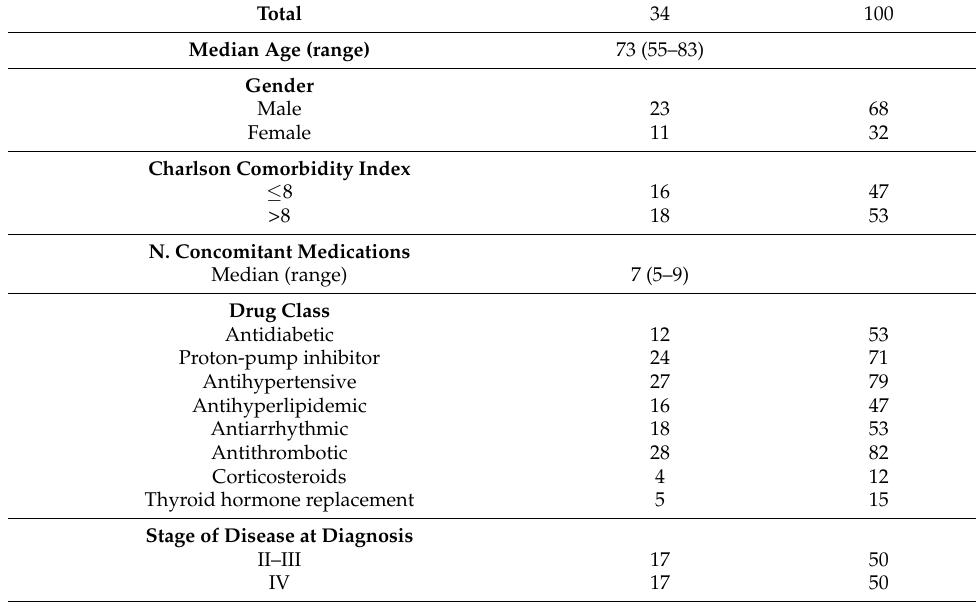
Table 1. Clinicopathologic features (valid cases and